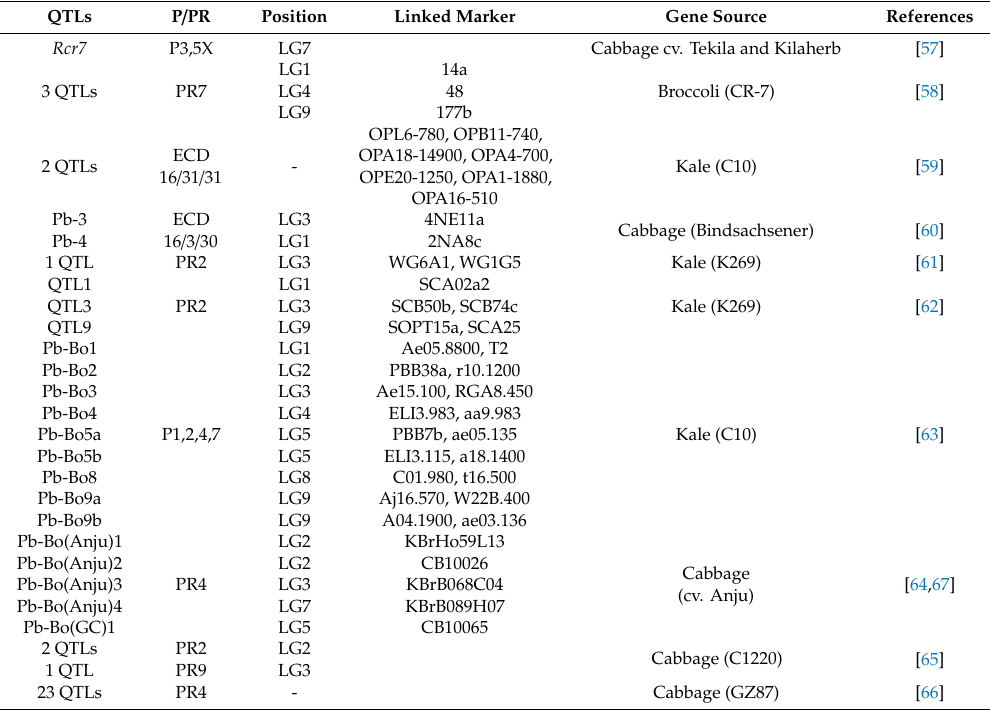
Table 2. CR loci reported on B. oleracea